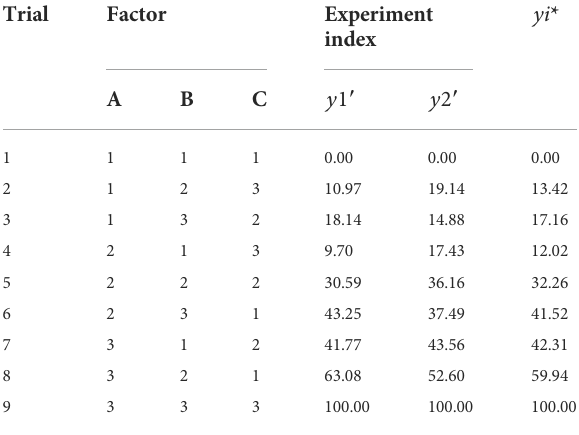
TABLE 3 Results of the orthogonal test using weight grade method of the nasal stent. Trial Factor Experiment